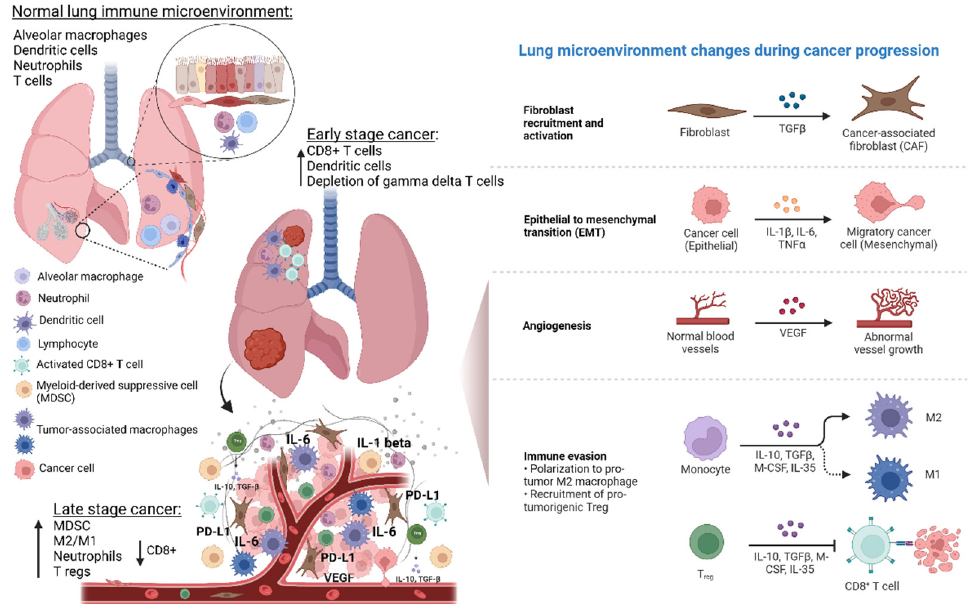
Figure 1. Lung microenvironment changes from physiological state to NSCLC development and progression. Normal lung microenvironment includes epithelial cells, smooth muscle cells, fibroblast, endothelial cells, and immune cells such as dendritic cells, neutrophils, T cells, and alveolar macrophages. The latter contribute to maintain immunological homeostasis, but they can also promote inflammation, and thus, development of premalignant lung lesions and carcinogenesis. During NSCLC development, the tumor microenvironment (TME) changes, thus contributing to inflammation angiogenesis, immune modulation, and therefore promoting NSCLC progression, metastasis, and prognosis. In particular, the immune TME, through specific reprogramming and modulation of T cells, tumor-associated macrophages (TAMs) and myeloid cell populations exert crucial tumor-promoting or tumor-suppressing activities. The switch from tumor immune surveillance to cancer immune escape is characterized by the recruitment of regulatory T-cells (Tregs) and upregulation